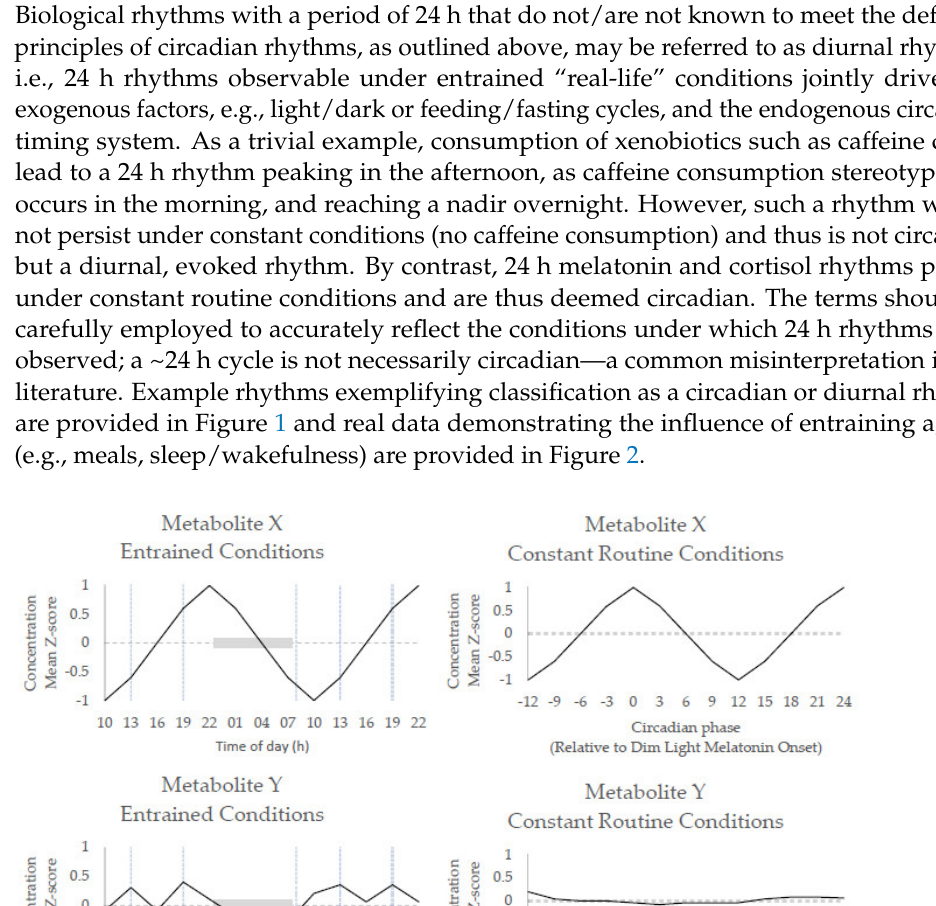
Figure 2. Comparative metabolite/hormone profiles under entrained conditions: sleep vs. pro- longed wakefulness ( A – C ), entrained vs. circadian constant routine conditions ( D ), and inter-indi- vidual variation under constant routine conditions ( E ), reproduced from Honma et al. [50] ( A ), Da- vies et al. [51] ( B , C ), Czeisler & Klerman [52] ( D ), and Chua et al. [53] ( E ). A,B,C: Comparative pro- files of cortisol, dodecanoylcarnitine (C12), and taurine under entrained light/dark conditions, sleep (highlighted in black) vs. prolonged wakefulness (highlighted in grey), with meals provided at 07:00 h, 13:00 h, 19:00 h, and 22:00 h (snack). No significant difference observed in cortisol, a SCN-driven